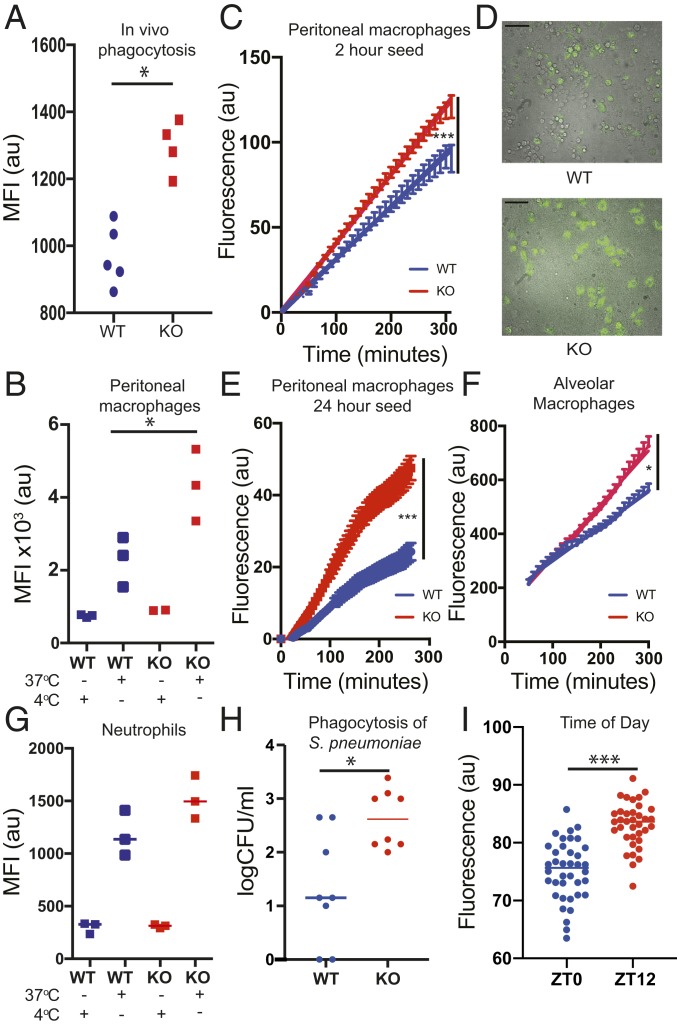
BMAL1 deletion improves macrophage phagocytosis. (A) LysM-Bmal1−/− mice and floxed controls were infected i.p. with S. aureus pHrodo green (SAPG). Peritoneal exudate cells were sampled after 45 min and subjected to FACS. The MFI was quantified (WT n = 5, LysM-Bmal1−/−
n = 4). *P < 0.05; Mann–Whitney U test. (B) Ex vivo phagocytosis assay. Peritoneal macrophages were incubated with SAPG for 4 h, before FACS analysis (gating strategy see SI Appendix, Fig. S1D). (n = 3 mice) (Mann–Whitney U test *P ≤ 0.05). Cells incubated with SAPG at 4 °C to inhibit enzymatic function in the macrophages are also shown. (C–E) Ex vivo live cell microscopy phagocytosis assays with representative combined brightfield and fluorescence image. Peritoneal macrophages were recovered from LysM-Bmal1−/− mice and floxed control mice, and seeded for (C and D) 2 h (WT, n = 48) positions, LysM-Bmal1−/−, n = 57 positions, quantification and representative fluorescent microscopy are shown. (Scale bar, 25 µm.) (E) At 24 h (WT n = 25 positions, LysM-Bmal1−/−
n = 30 positions). SAPG was added to the cultures and the increase in MFI measured (mean and SEM plotted repeated measures ANOVA ***P < 0.0001). For representative FACS plot see SI Appendix, Fig. S2D. (F) Alveolar macrophage live cell microscopy phagocytosis assay. (n = 10 positions). (G) Ex vivo neutrophil phagocytosis assay. Bone marrow-derived neutrophils from LysM-Bmal1−/− were plated in vitro and subject to the same phagocytosis protocol as B. After 4 h, there was no genotype effect (P = 0.2, Mann–Whitney U test). (H) Ex vivo S. pneumoniae phagocytosis assay. Peritoneal macrophages were incubated with S. pneumoniae, D39. At 4 h after challenge, viable intracellular bacteria were assessed (n = 8, Mann–Whitney U test *P ≤ 0.05). (I) Peritoneal macrophages from C57BL/6 mice were subjected to live cell phagocytosis assay with labeled S. aureus at ZT0 and ZT12. (n = 36 to 38 wells per time of day) (Mann–Whitney U test ***P < 0.0001).